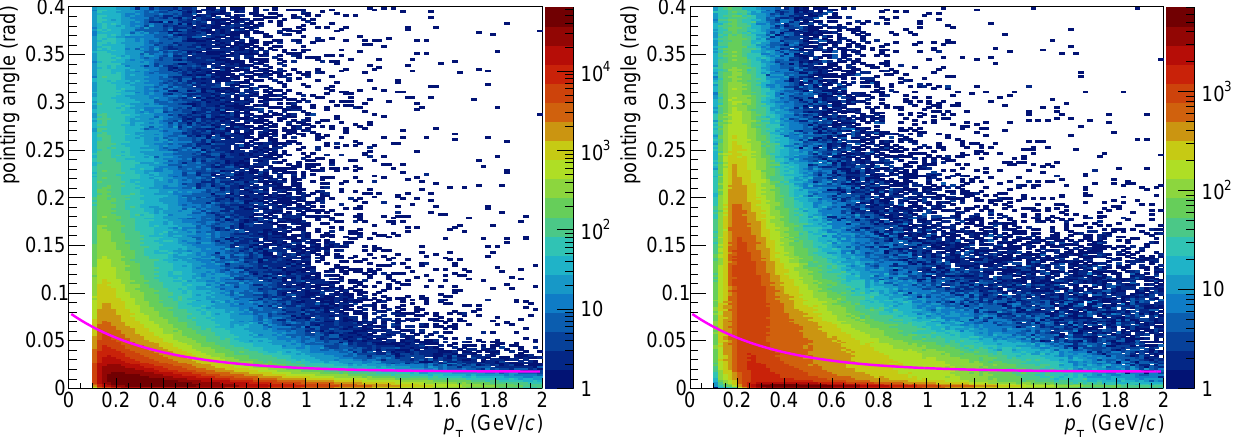
Figure 6. Distributions of signal ( left ) and background ( right ) events as a function of the pointing angle and transverse momentum of the photon pair. Selection limits are shown with magenta